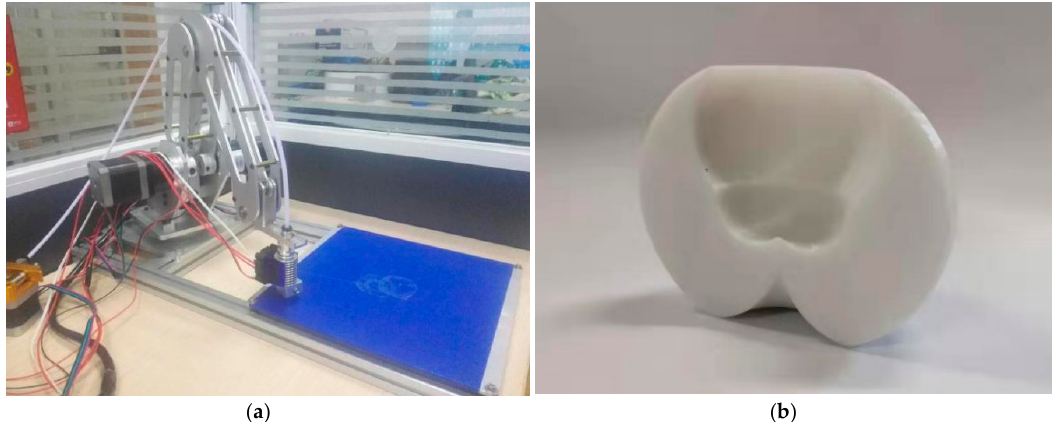
Figure 15. ( a ) The 3D-printing system robot; ( b ) a 3D-printed object of the workspace